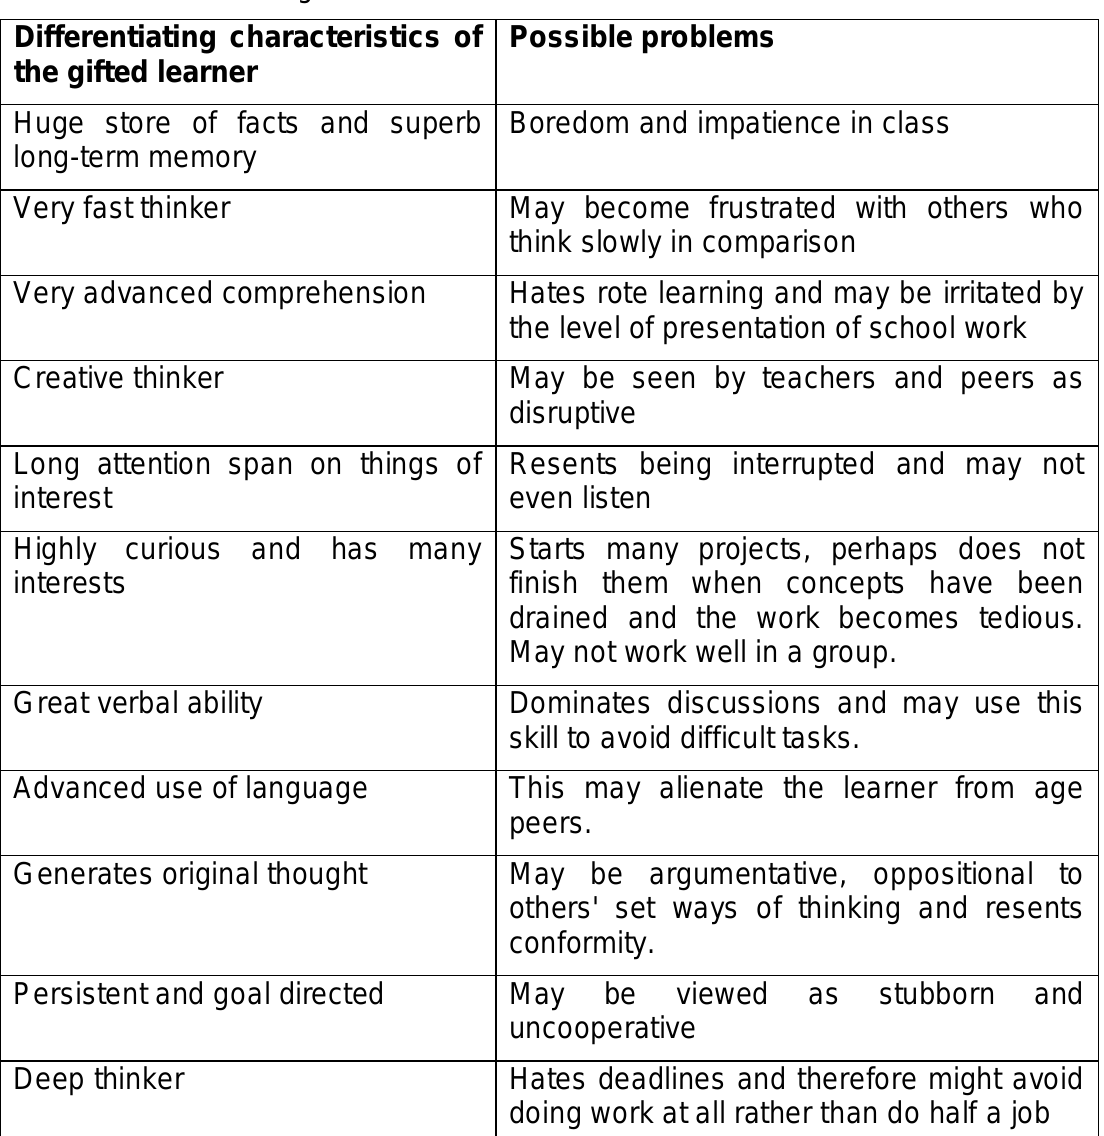
Table 2.1: Possible concomitant problems resulting from